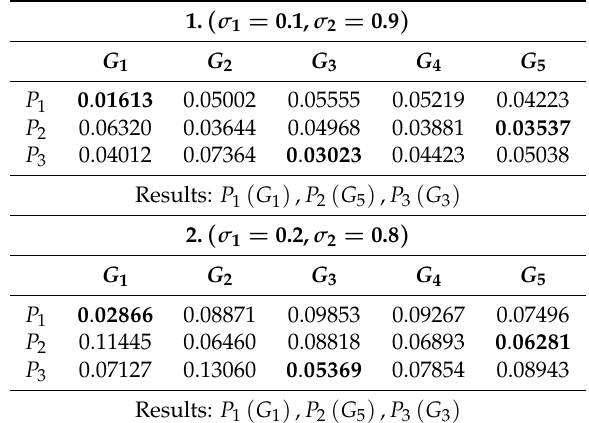
Table 1. Diagnosis Results for Picture Fuzzy Divergence